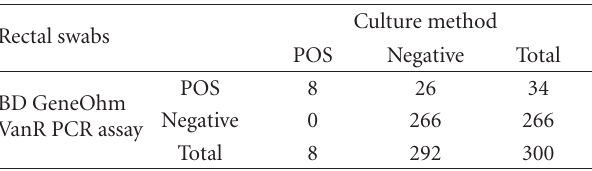
Table 4: Comparison of BD GeneOhm VanR Assay and culture in the detection of VRE with rectal